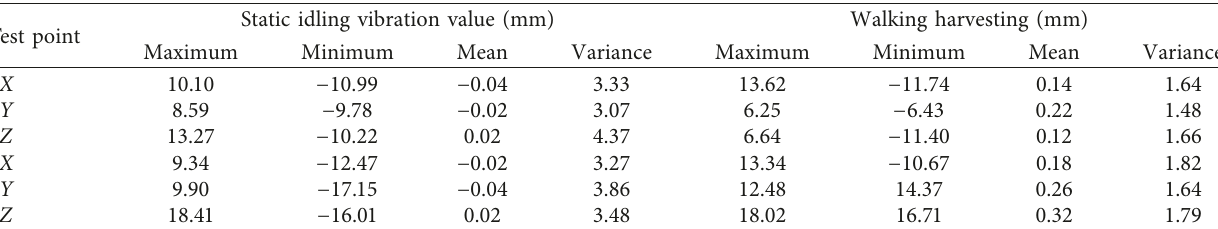
Figure 19: Vibration signal of X - Y - Z direction. (a) X direction signal. (b) Y direction signal. (c) Z direction signal. Table 4: Vibration amplitude test results at 2 points.